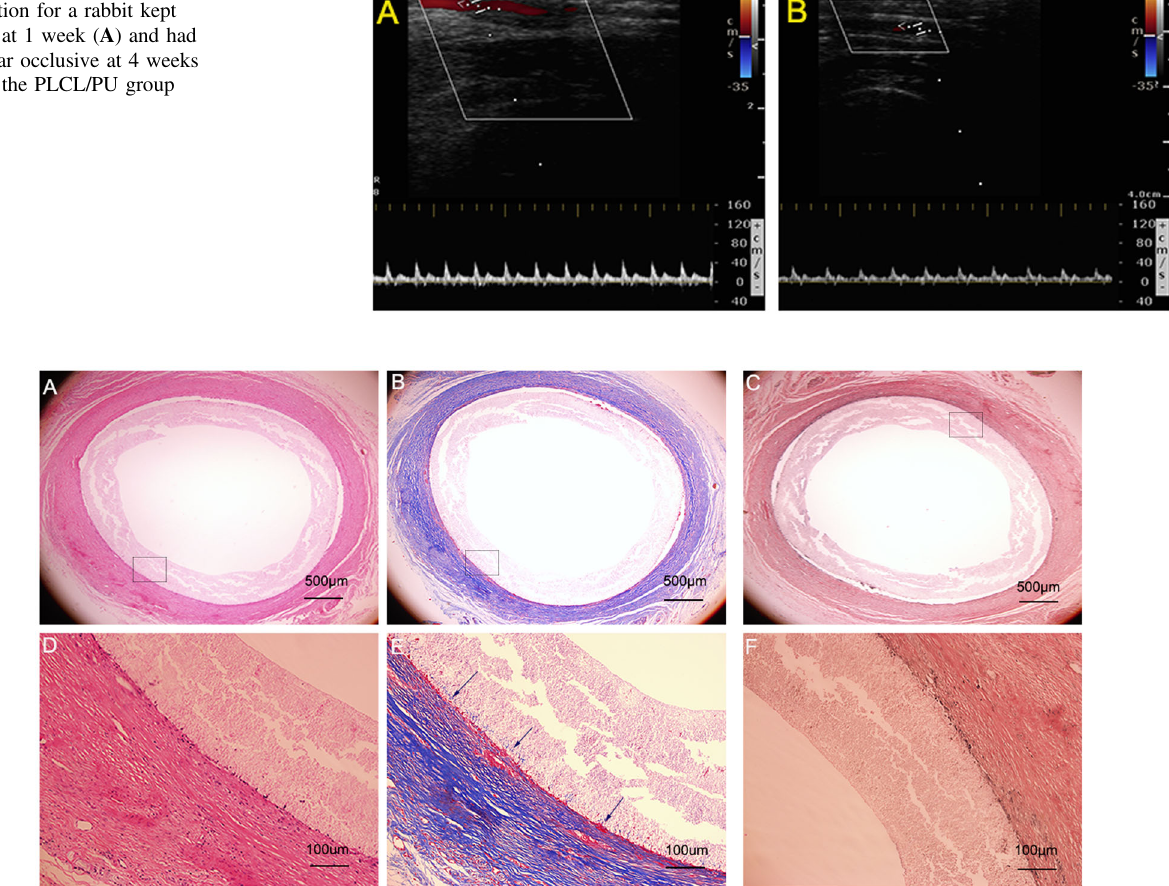
labeled by the rectangle). Partial enlarged image of haematoxylin and eosin ( D ), Masson ’ s trichrome ( E ) (The blue part indicated by the arrow was the collagen fi ber), Elastica van Giessen ( F